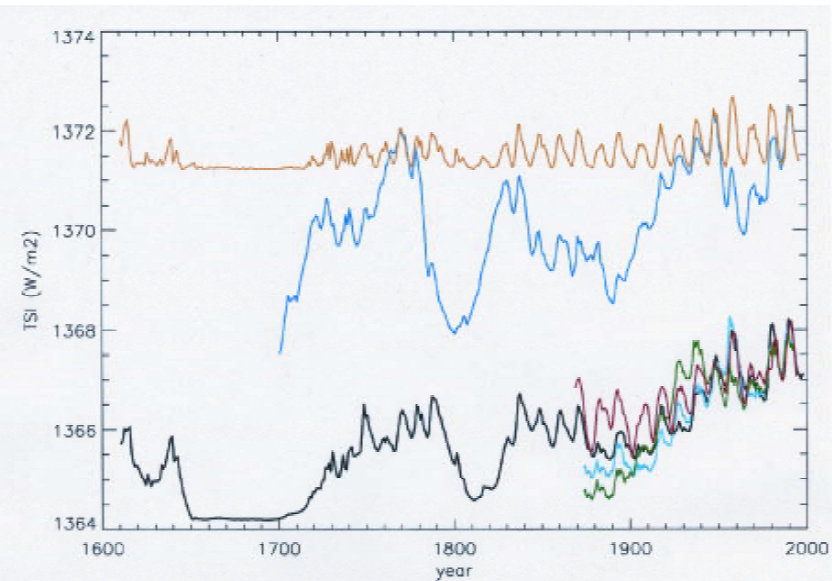
FIGURE 12. Proxy reconstructions of solar irradiance from two methods: blue[52] and black[53] with two more recent determinations and assumed forcing simply due to sunspot numbers calibrated with satellite irradiance observations from the past 20 years.